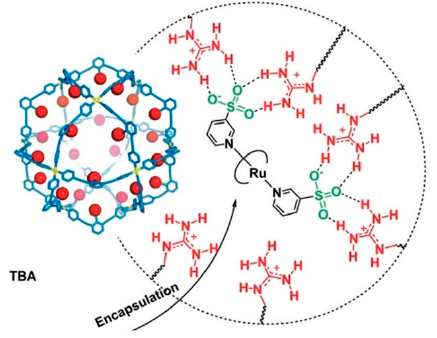
Figure 8. Ru-guanidinium nanosphere with incorporated ruthenium complex. Adapted with permission from (Yu et al., 2018) [90]. Copyright 2018 Wiley.